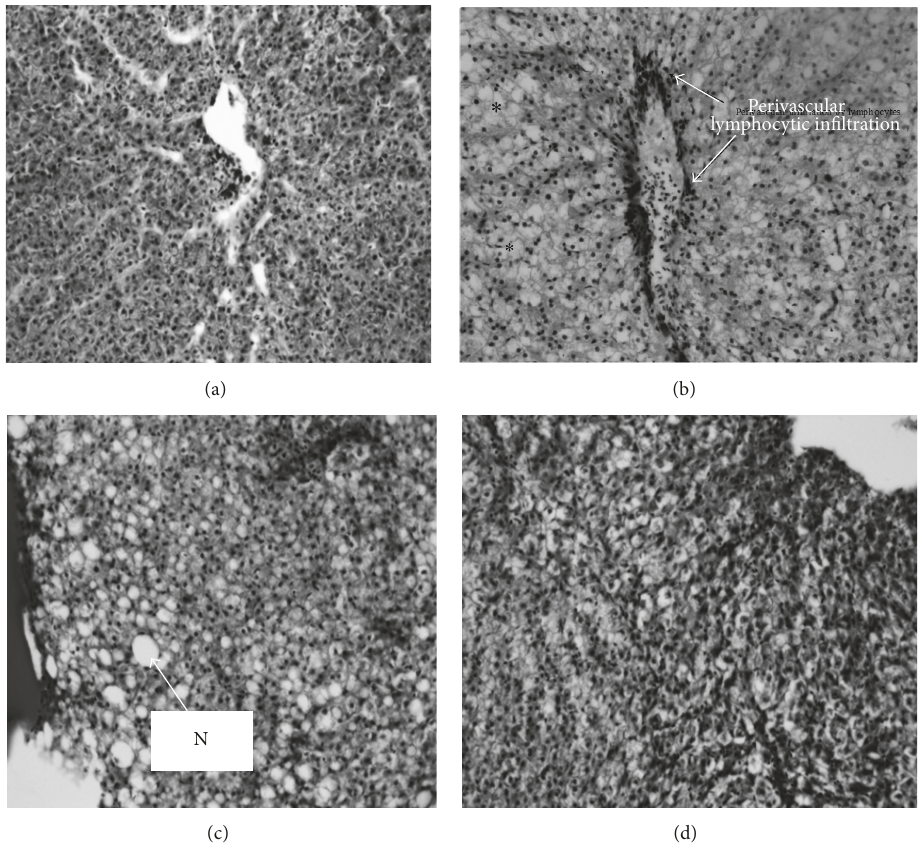
Figure 1: Histology of a liver in O. niloticus fed with Diet 1 (a), Diet 2 (b), Diet 3 (c), and Diet 4 (d) for 24 weeks. H&E; bar = 400 𝜇 m. ∗ N: fatty